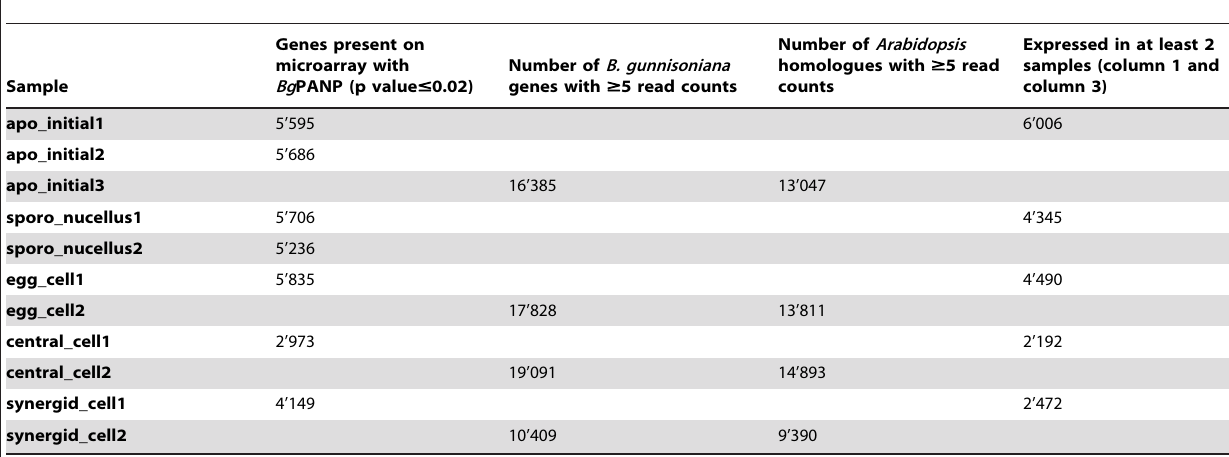
Table 1. Transcriptome analysis of 11 samples from apomictic Boechera isolated by LAM.